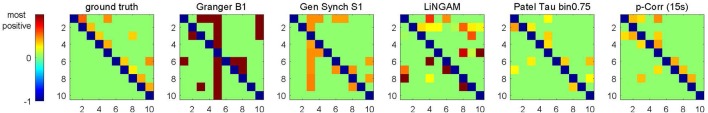
Images of aj|i (for ground truth) and dj|i (for constrained p-correlation), and quantities analogous to dj|i (for Granger B1, Gen Synch S1, LiNGAM, and Patel) for Subject 14 of Sim2. Each image uses the same ordering of colors, but has different range of numerical values.